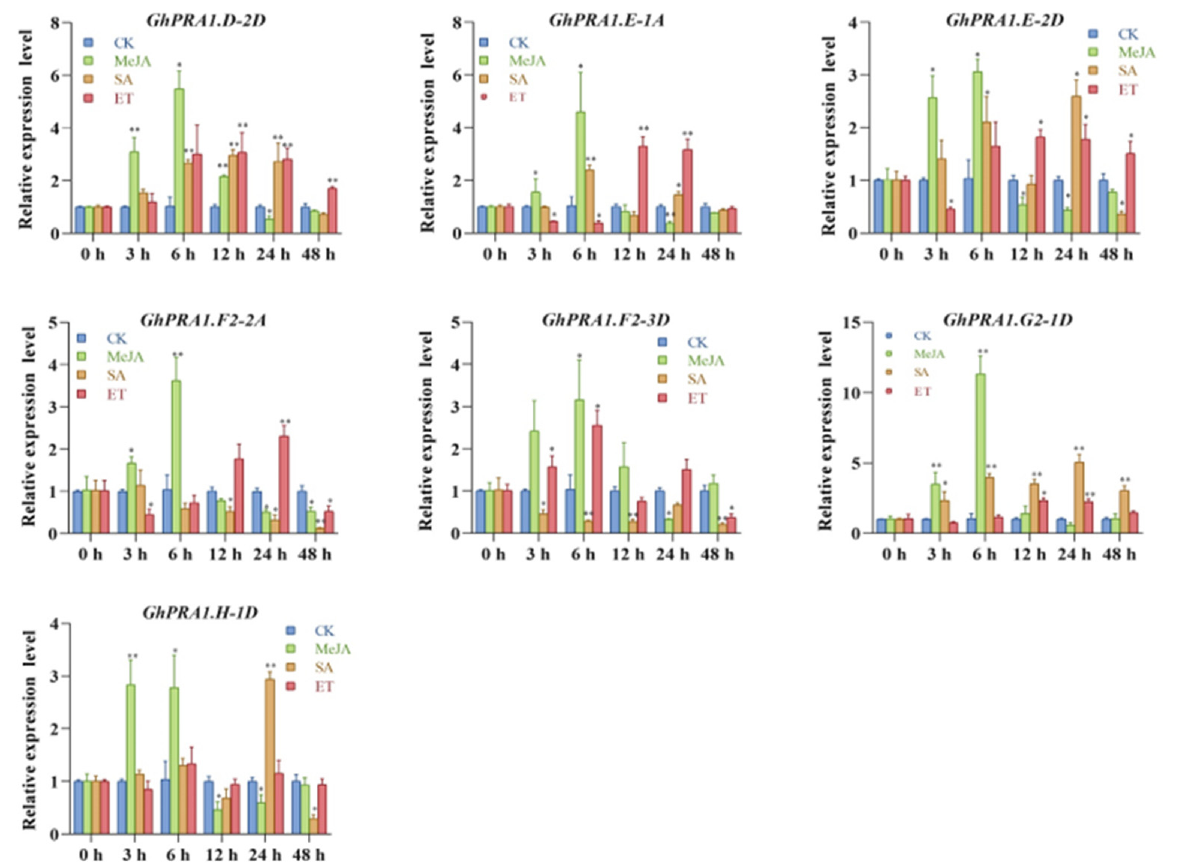
Figure 6. Expression profiles of GhPRA1 genes under treatment with different plant hormones. Statistically significant differences are indicated as follows: * p < 0.05, ** p <